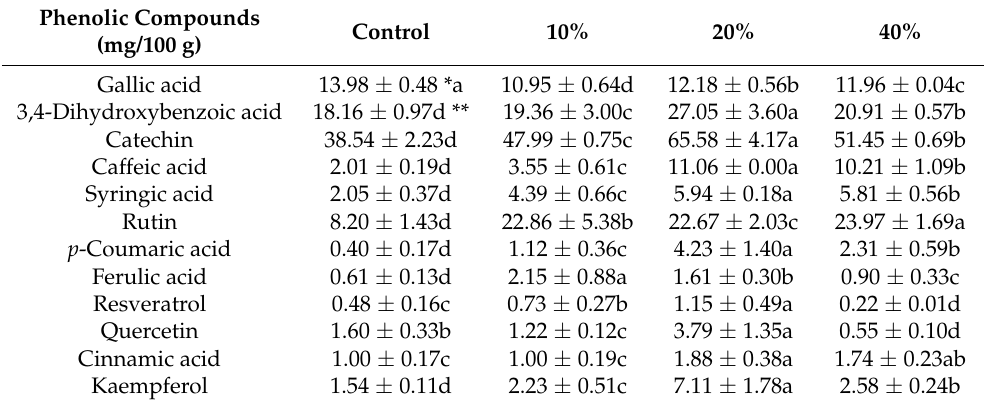
Table 2. Phenolic compounds of bread samples enriched with chufa flour at different concentrations *.